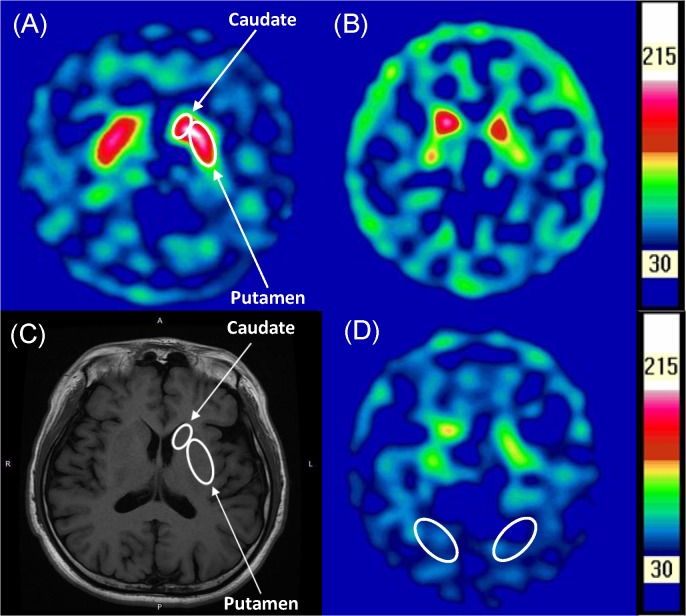

99mTc-TRODAT-1 with single photon emission computed tomographic images of a control subject (A) in comparison with an age matched alcohol-dependent patient (B) in transverse slices at the level of striatum, and the corresponding MRI for the control subject (C).Regions of interest shows are for caudate and putamen (A and C), and for occipital lobe which is the reference region (D).